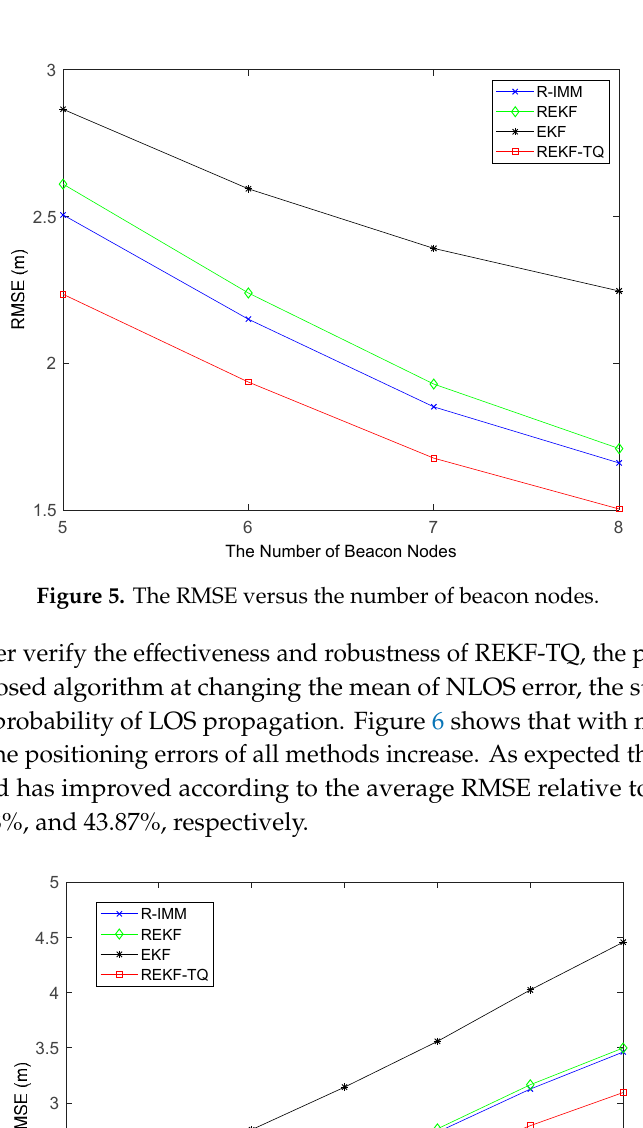
13 of 24 Figure 4. The localization error CDF.